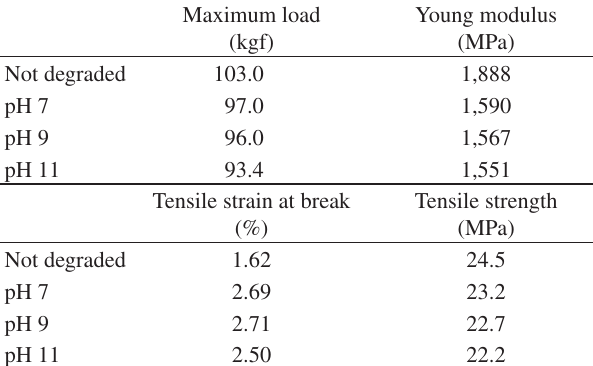
Table 8. Mechanical properties of PHB/PP (90/10) after accelerated degrada- tion in